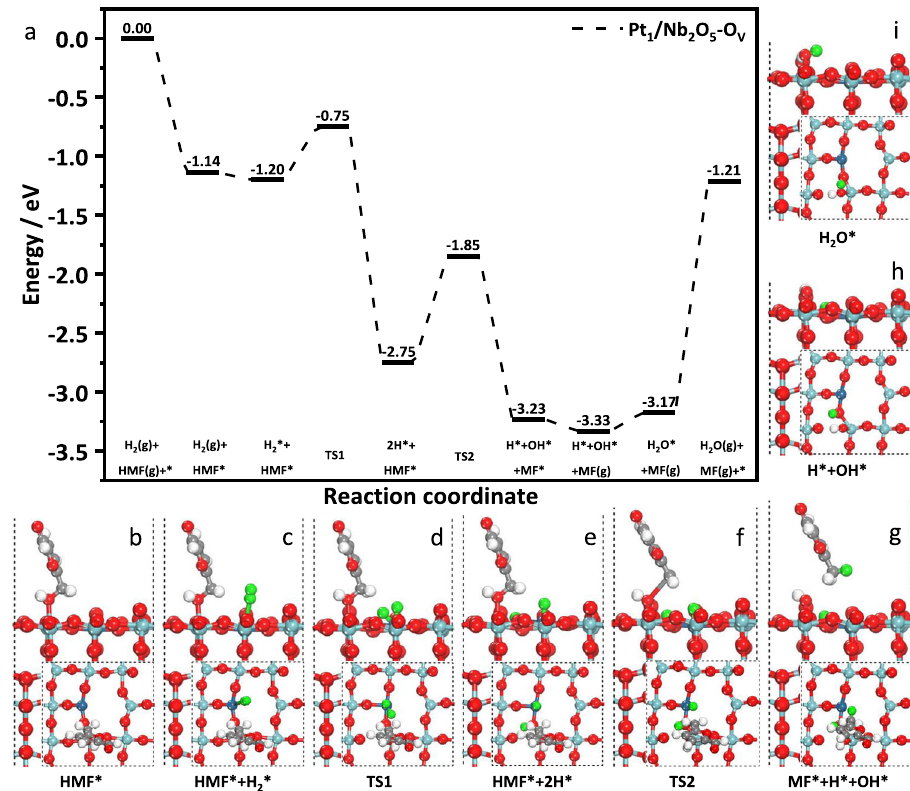
Fig. 6 Reaction pathway based on DFT calculations. Calculated energy pro fi le of a HMF hydrogenation on Pt 1 /Nb 2 O 5 -Ov surfaces, as well as b – i are the key structures of HMF hydrogenation. Silver: C, white: H, red: O, light blue: Nb, blue: Pt, green: H (Hydrogen).